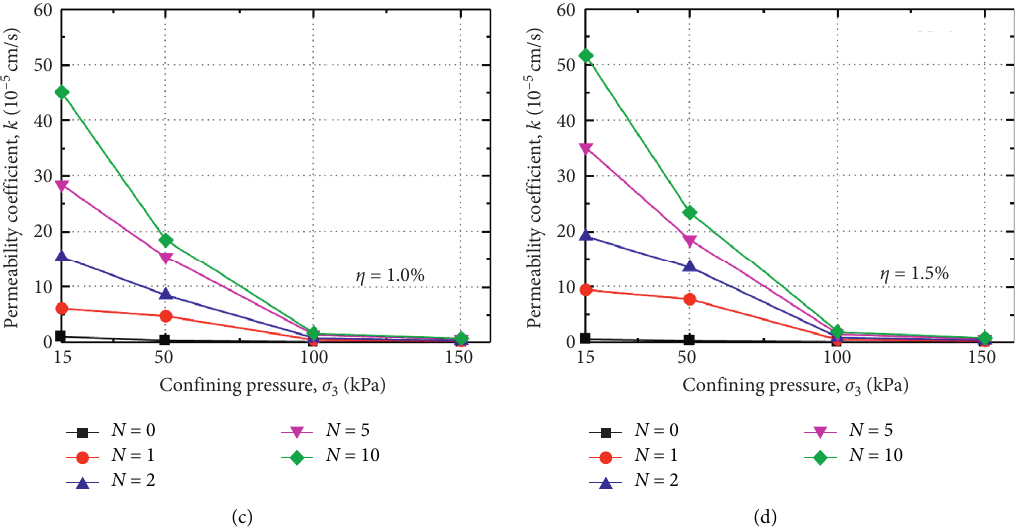
Figure 6: Permeability coefficient of saline intact loess at various confining pressures. (a) η � 0.0%, (b) η � 0.5%, (c) η � 1.0%, and (d) η � 1.5%.